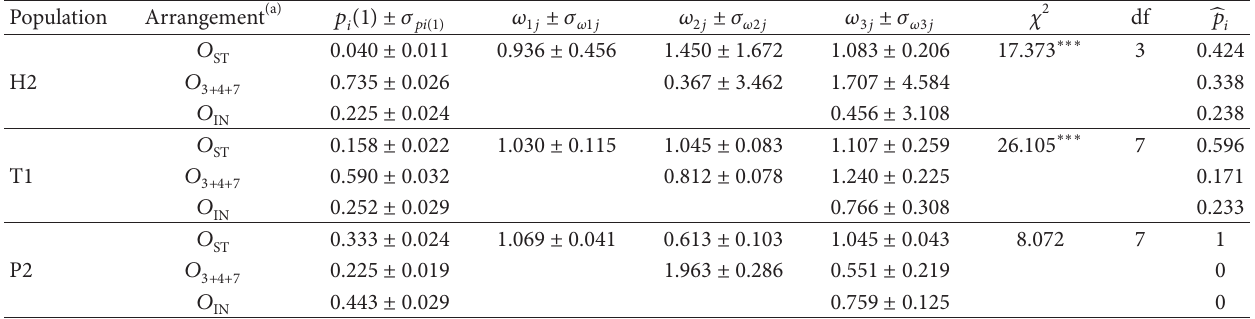
T 1: ML estimates of frequency-, sex-, and stage-independent adaptive